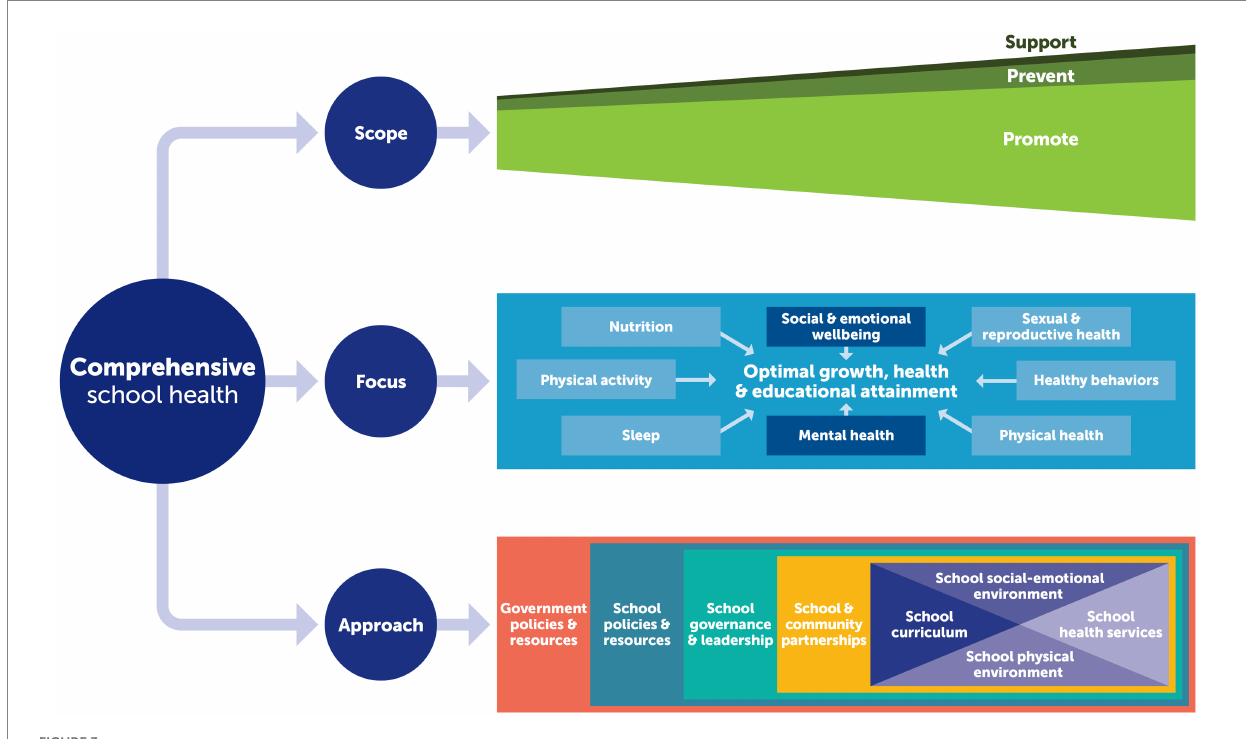
FIGURE 3 Elements of comprehensive school health included aspects of scope, focus, and